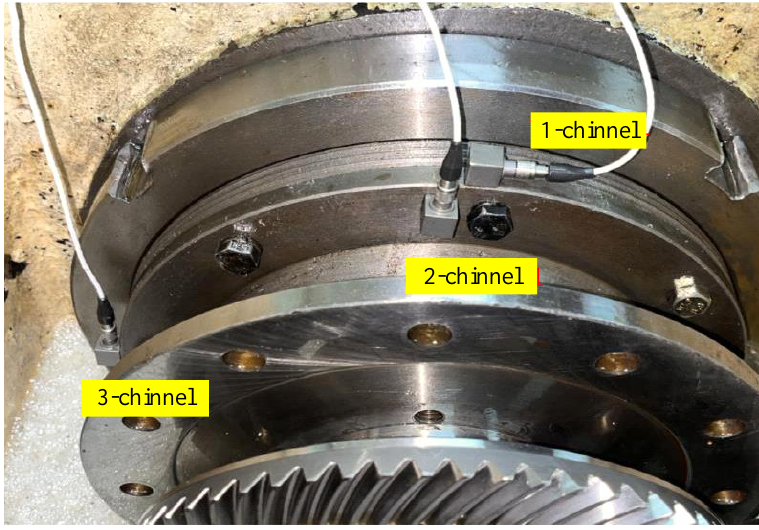
Figure 3. Arrangement of sensors on the tested gearbox.